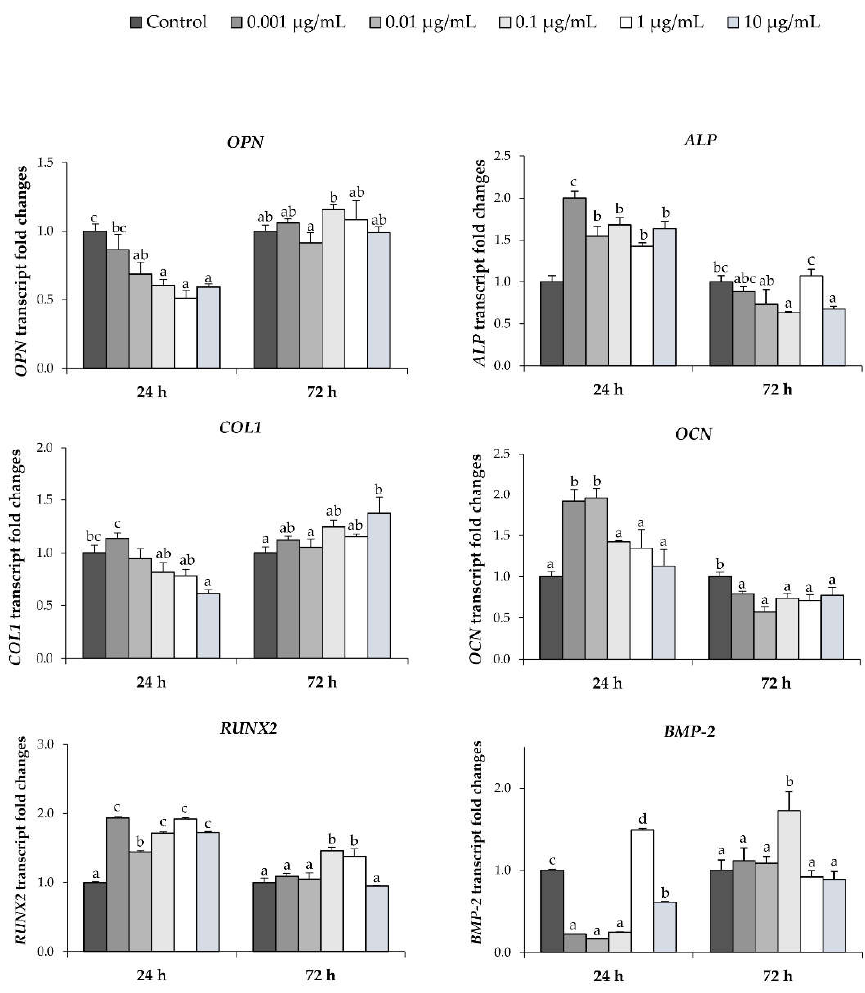
Figure 4. Analysis of mRNA level expressions of OPN , OCN , COL1 , ALP , RUNX2 , and BMP-2 by quantitative real-time polymerase chain reaction (PCR). MC3T3-E1 cells were treated with Ps -GOS in various concentrations for 24 and 72 h. The data were obtained from three independent experiments in four replicates as mean ± SEM. The data in columns with di ff erent letters in each group were significantly di ff erent at p < 0.05.